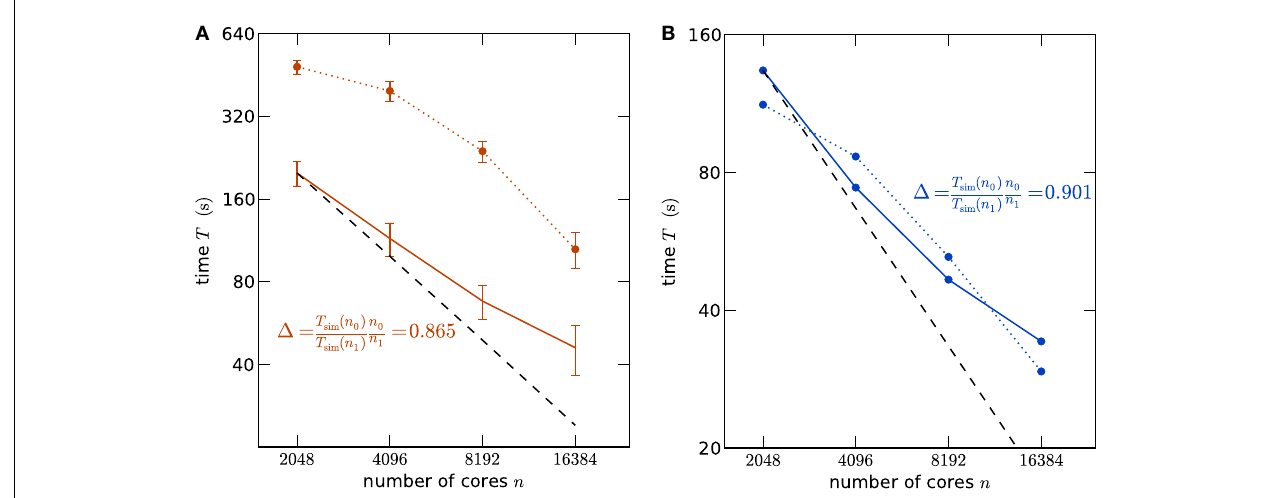
(0.865).The error bars denote the standard error of the mean from 5 repetitions of identical simulations (same random numbers).The setup time (allocation and creation of neuron objects and synapses) is shown by the dotted curve. (B) Strong scaling for a network of N = 1,126,400 neurons on JUGENE. At 2048 cores the network consumes all available memory. Same symbol code used as in (A)